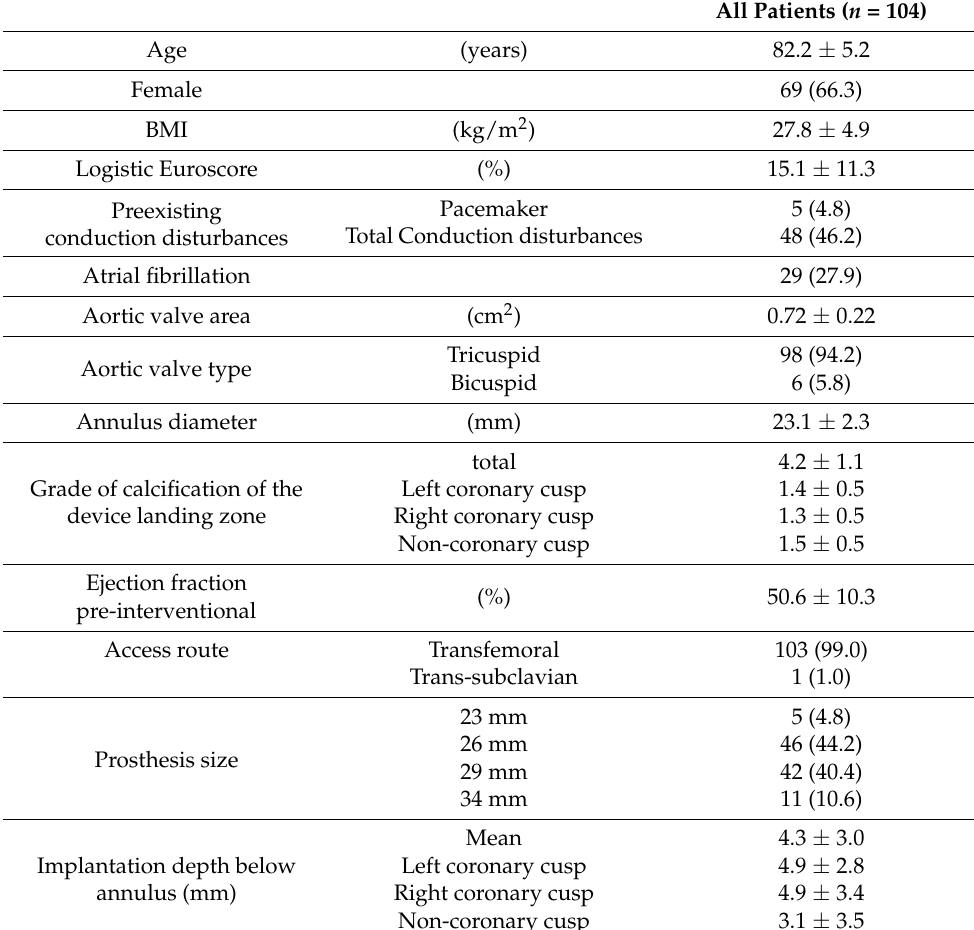
Table 1. Baseline, procedural and prosthesis-related characteristics of the entire study